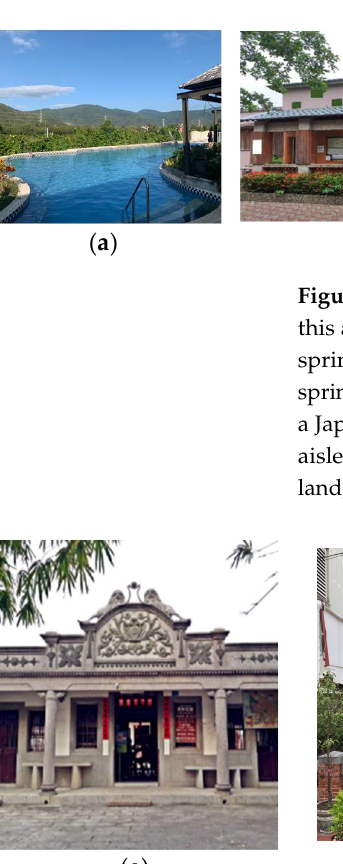
hot spring is free of charge for local residents and tourists, and was built in 1985; ( c ) The hot spring